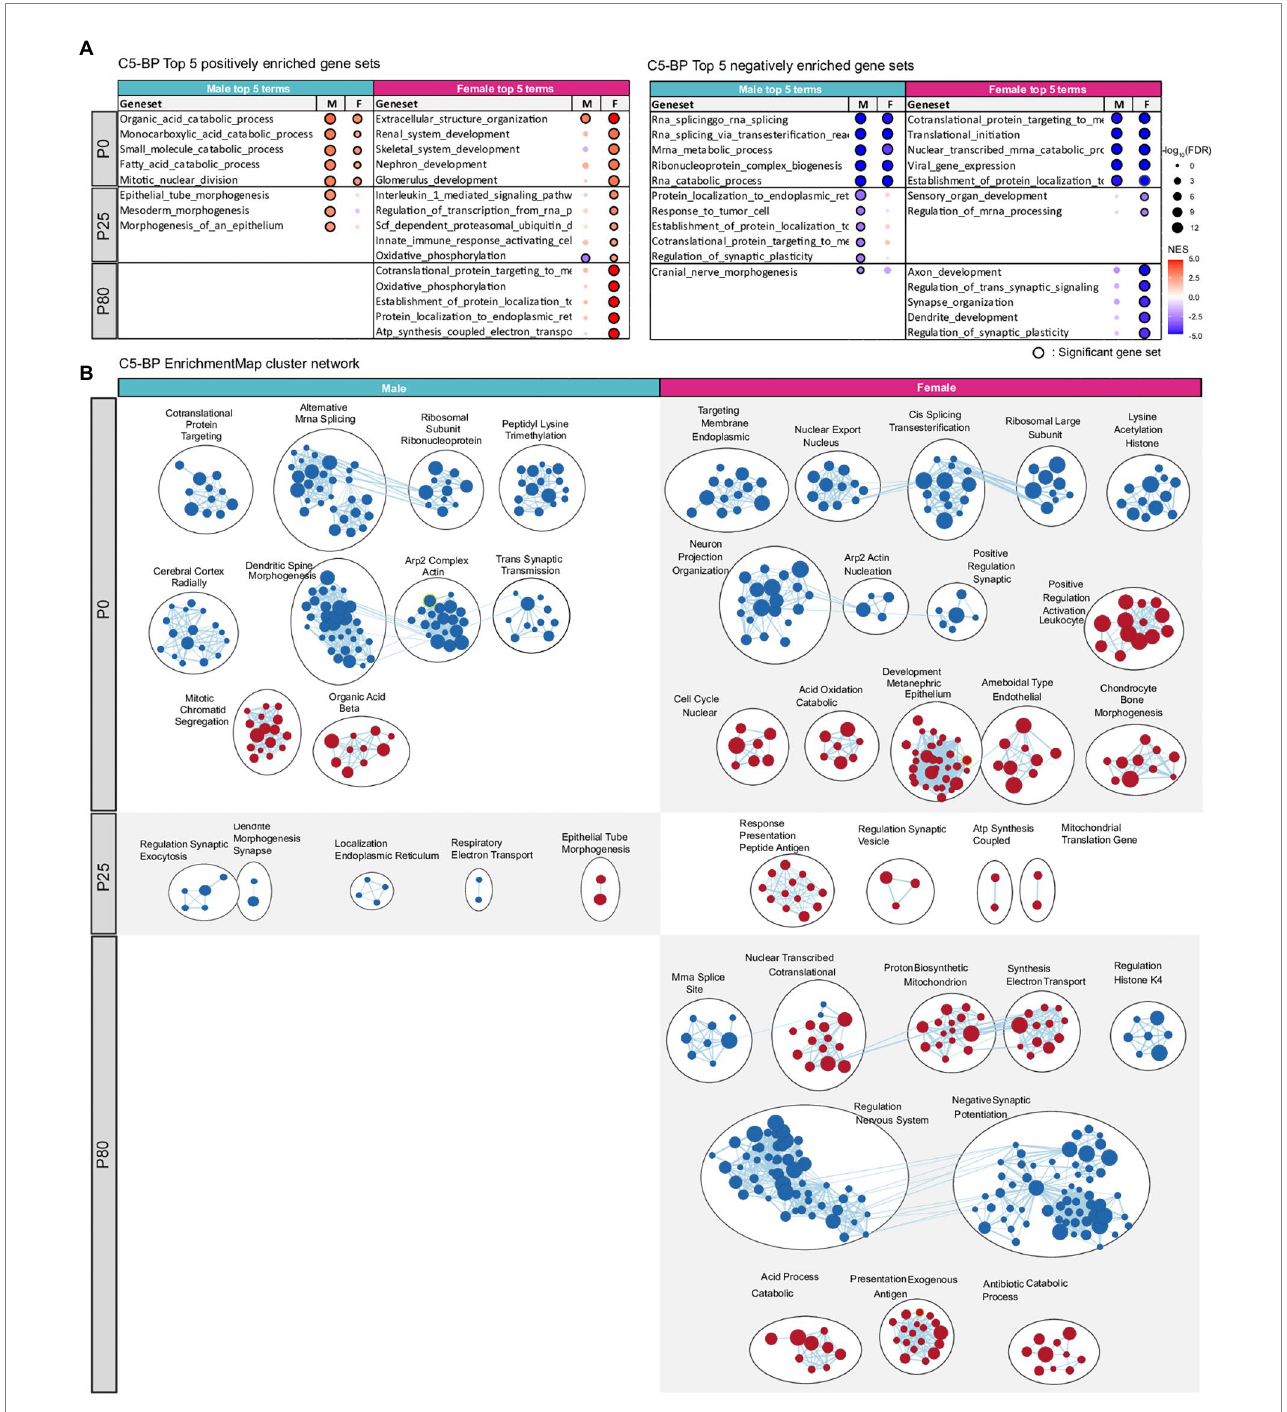
FIGURE 6 Transcriptomic changes in Chd8 +/S62X males and females for gene sets in the biological process domain. (A) GSEA of P0, P25, and P80 male and female HT/ WT transcripts for gene sets in the biological process (BP) domain of the C5 database (http://software.broadinstitute.org/gsea). Top-five gene sets positively or negatively enriched in male or female transcripts are listed, together with the same gene sets in the other sex and their enrichment levels (see Supplementary Tables S5–S7 for complete results). ( n = 3 mice for P0/P25/P80 male/female mice, FDR (false discovery rate) < 0.05; NES, normalized enrichment score). (B) Integration and visualization of enriched genes in larger clusters using Cytoscape EnrichmentMap. ( n = 3 mice for P0/25/80 male/ female mice; node cutoff, FDR < 0.05 and p < 0.001; edge cutoff, overlap coefficient >